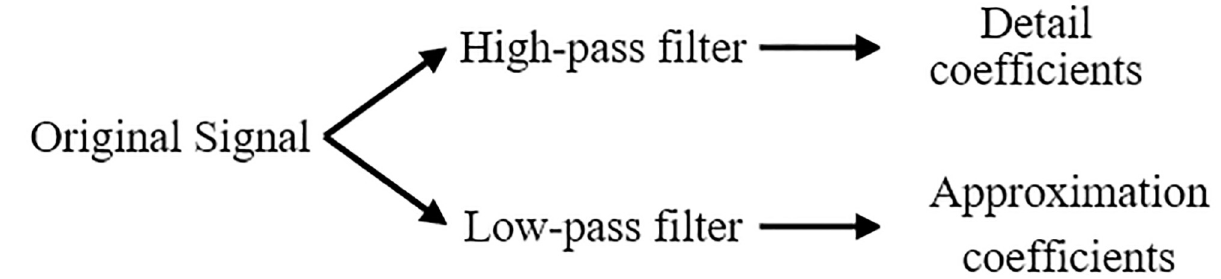
Fig 1. Discrete wavelet transform decomposition